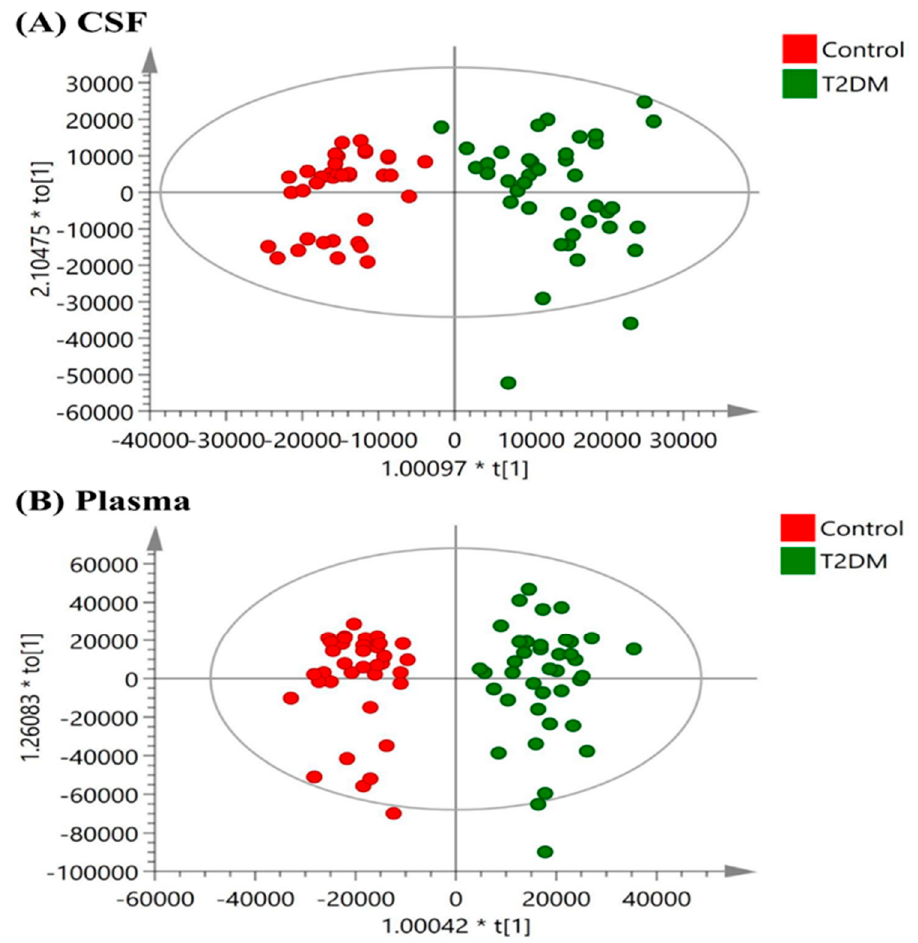
Figure 2. Orthogonal partial least-squares discriminant analysis (OPLSDA) score plots in ( A ) CSF (reliability: R 2 X = 0.757, R 2 Y = 0.852, Q 2 = 0.677) and ( B ) plasma (reliability: R 2 X = 0.905, R 2 Y = 0.904, Q 2 = 0.733) samples obtained from T2DM patients versus controls. The OPLSDA plots show a clear separation between T2DM and the control group in CSF and plasma samples.